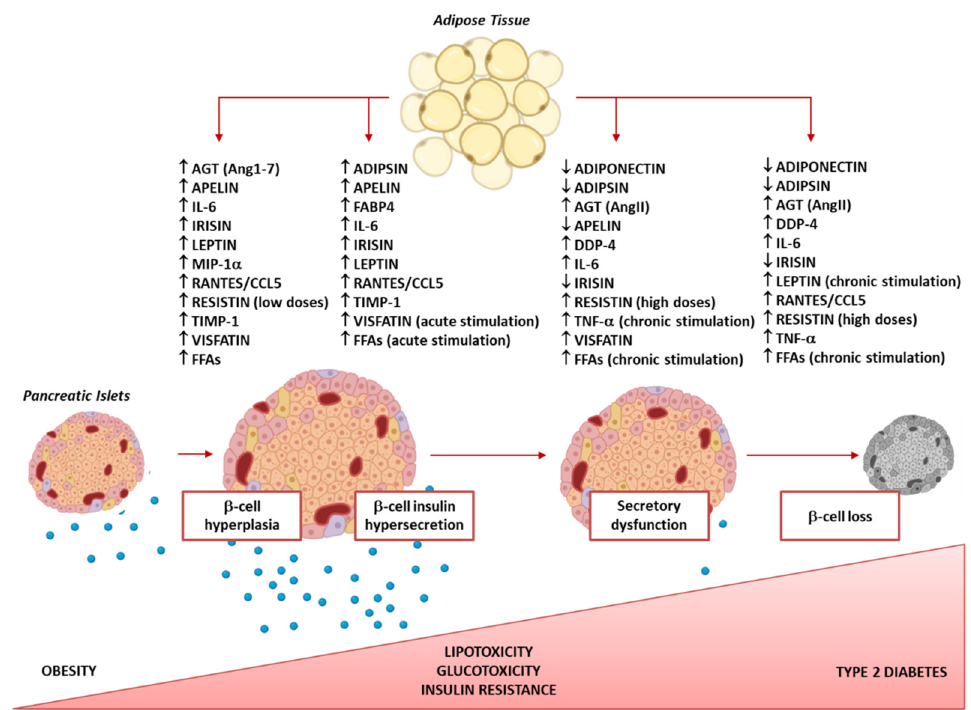
Figure 1. Timeline of the possible alterations in the adipokines secretion pattern in the transition from obesity to T2D that reflects the progressive deterioration of β -cell functional mass. ↑ , increased levels; ↓ , decreased levels. AGT, angiotensinogen; AngII, angiotensinogen II; DPP-4, dipeptidyl peptidase-4; FABP4, fatty acid-binding protein specific for adipocytes; FFAs, free fatty acids; IL-6, interleukin-6; MIP-1 α , macrophage inflammatory protein-1 α ; RANTES, regulated upon activation normal T cells, expressed and secreted; TIMP-1, tissue inhibitor of metalloproteinases-1; TNF- α , tumour necrosis factor- α .